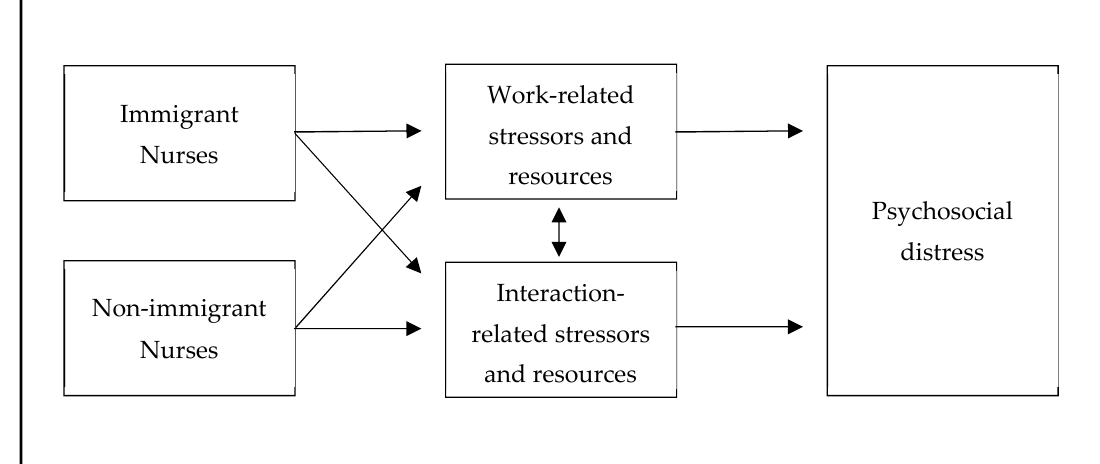
Figure 1. A theoretical framework for the study.